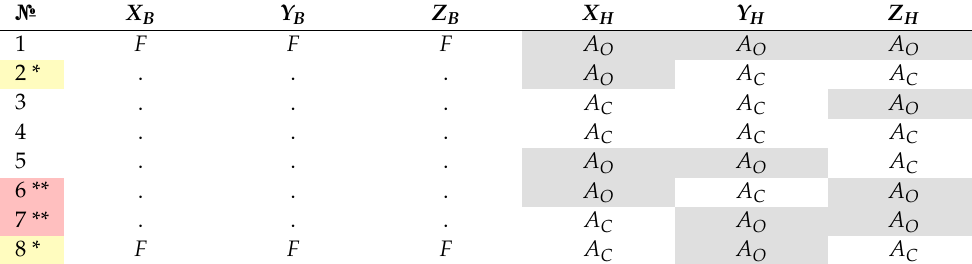
Table A2. Fixed axes X B , Y B , Z B and actuated axes X H , Y H , Z H . № X B